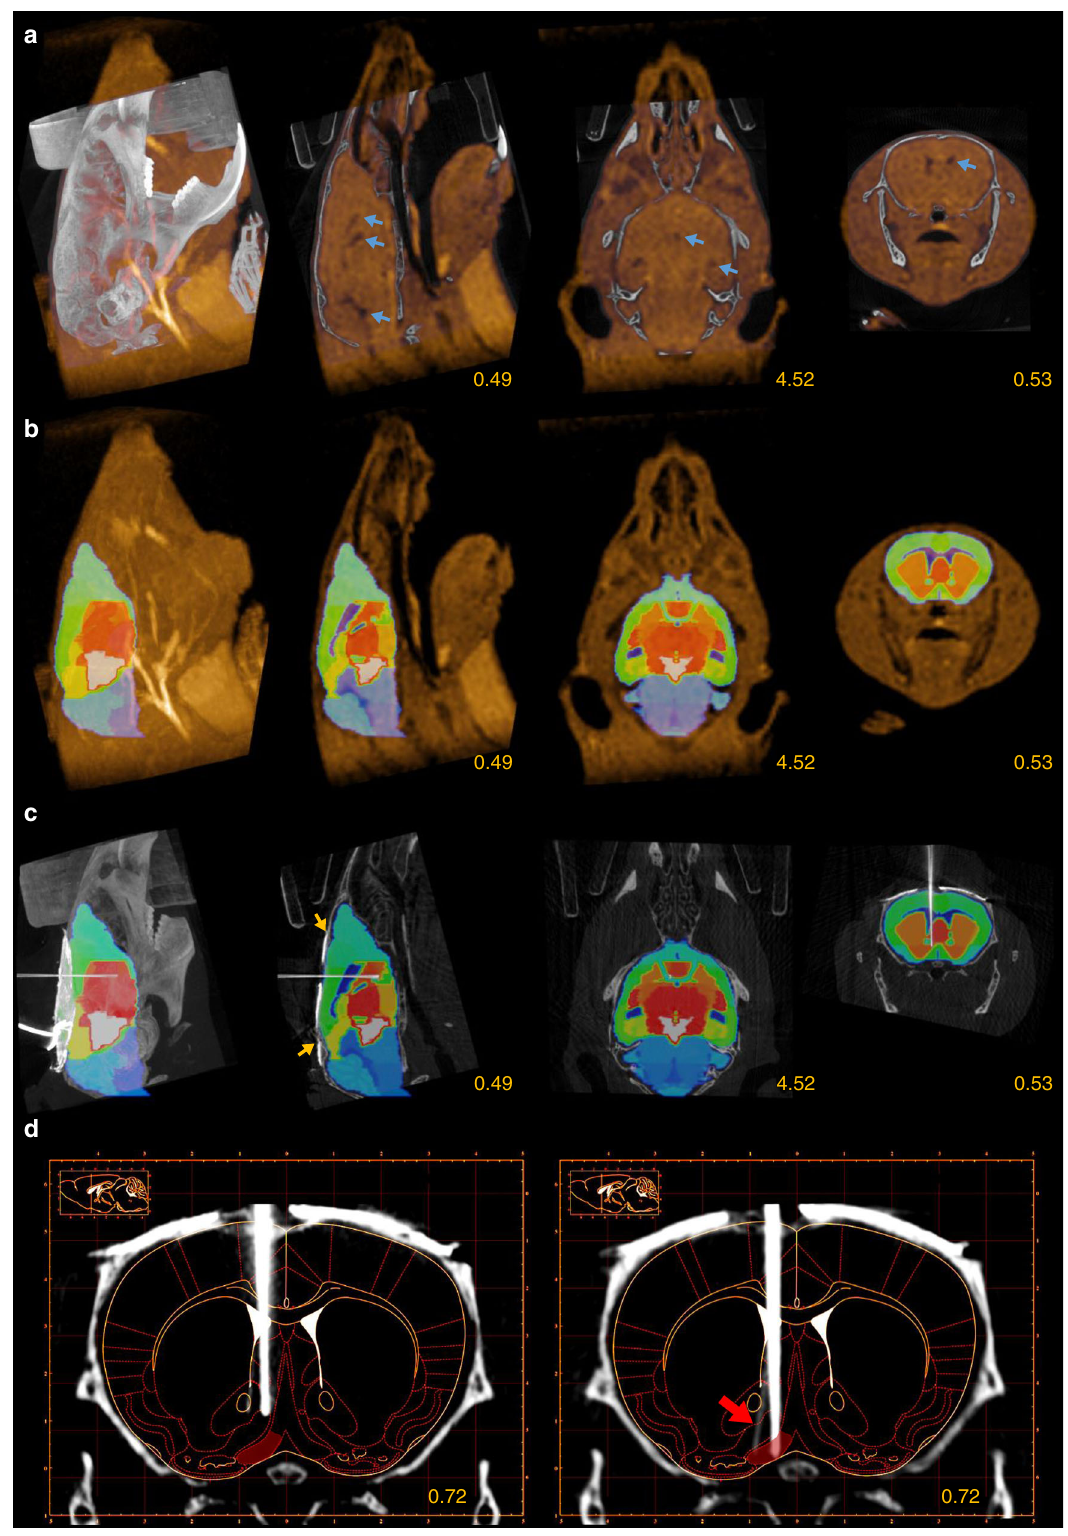
Fig. 4 Implant localization based on CT – MRI fusion. a Preoperative CT and MRI images were fused (same mouse as in Fig. 2). Blue arrows show the ventricles on the MRI image used for atlas co-registration. Images from left to right, maximum intensity projection, sagittal slice, horizontal slice, and coronal slice. Yellow numbers refer to the corresponding stereotaxic coordinates in mm relative to Bregma. b A 3D MRI atlas was co-registered with the MRI image. c The 3D atlas was co-registered with the postoperative CT image. Yellow arrows show Lambda and sinus frontalis. d The corresponding coronal plane of the Paxinos atlas was fi tted on a coronal slice containing the tip of the implant after surgery (left) and at the end of the electrophysiology experiment (right). The fi gures clearly show that the implanted tetrodes went through the target area (HDB, red shading) during the experiment. The red arrow shows a tetrode that separated from the bundle. CT and MRI images are shown in grayscale and goldscale,